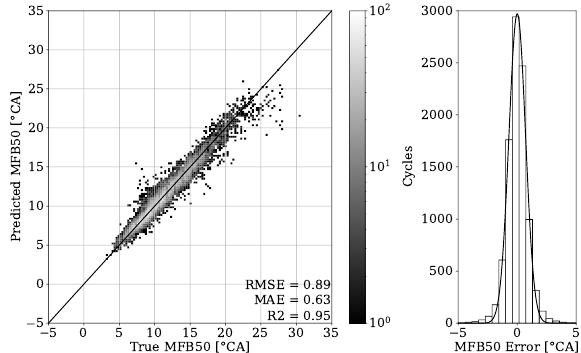
Figure 19. MFB50 regression of validation set from engine 1.